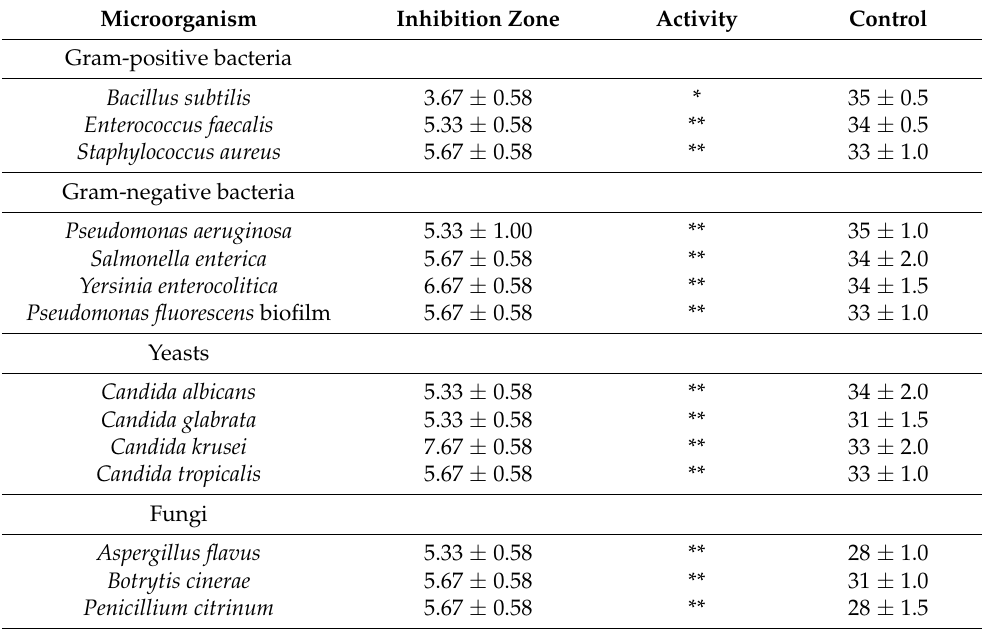
Table 4. Antimicrobial activity of ( E )-caryophyllene in